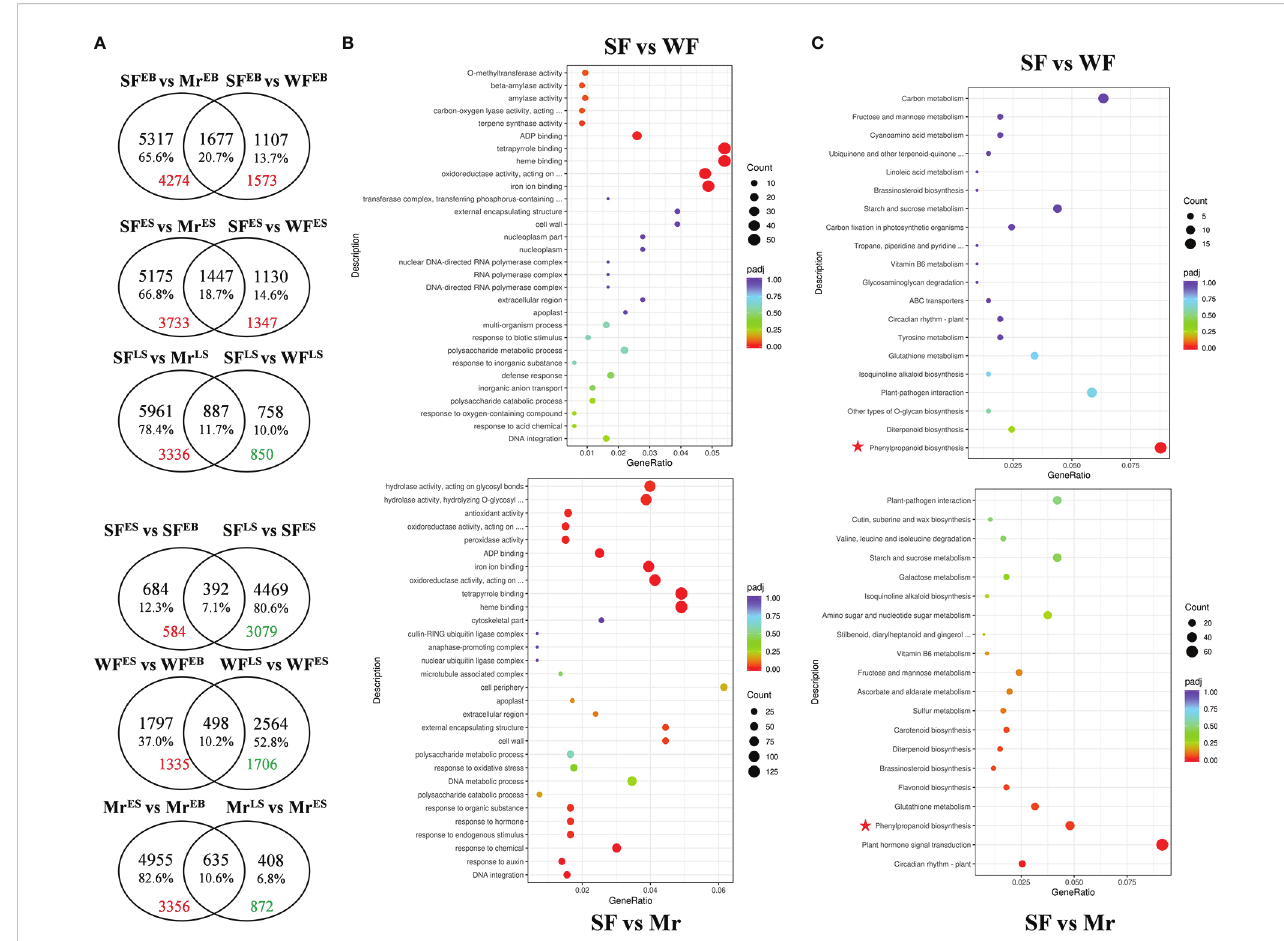
FIGURE 3 Venn diagram, GO terms, and KEGG pathways for differentially expressed genes (DEGs). (A) Venn diagram of genes expressed in the different plant materials and fl oral development stages. The intersections indicate the number of genes in common. Red and green numbers indicate the number of up- and down-regulated DEGs, respectively, in the corresponding pair. (B, C) GO terms and KEGG pathways for comparisons of samples (SF vs WF and SF vs Mr) at the ES stage. Different colors for p adj indicate the signi fi cance level, and the count size indicates the number of DEGs. Red asterisks indicate the common pathway in the comparison of SF with WF and